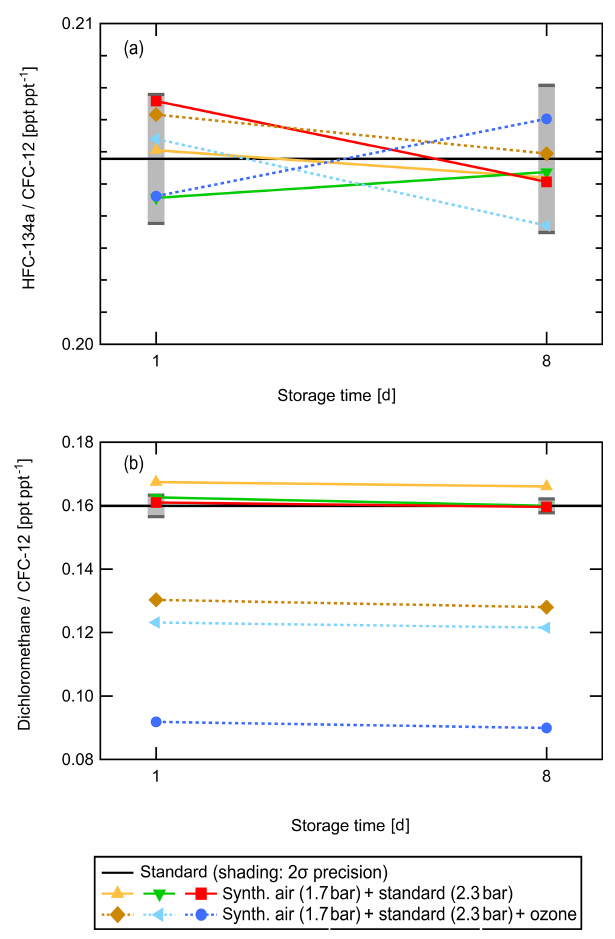
Figure 3. Results of the ozone and short-term storage test for HFC- 134a (a) and dichloromethane (b) . The ratio of mixing ratios of the respective compound relative to that of CFC-12 to cancel di- lution uncertainties is shown. The solid black line represents the value expected from direct measurements of the standard gas and the synthetic air. Grey shading indicates the 2 σ experimental uncer- tainty range around the expected value; error bars of individual data points are omitted for clarity. Colours represent different canisters filled with the gas mixture indicated in the legend; each canister was measured twice, i.e., 1d after pressurization and again after 8d of